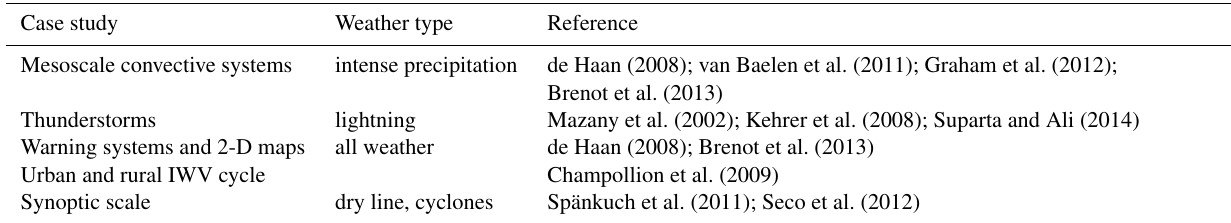
Table 6. Case studies of severe weather and operational nowcasting